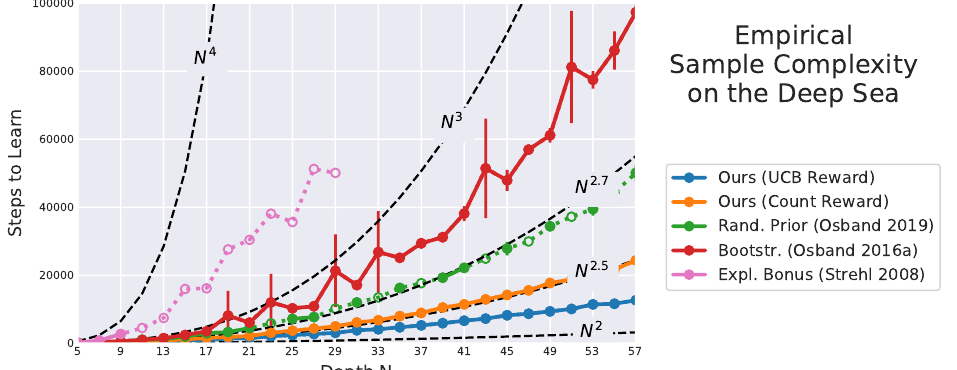
Figure 22. Steps to learn on varying the deep sea size N = 5,7, . . . ,59, averaged over ten runs with 500,000 steps limit. For filled dots, the run always converged, and we report the 95% confidence interval with error bars. For empty dots connected with dashed lines, the algorithm did not learn within the step limit at least once. In this case, the average is over converged runs only and we do not report any confidence interval. Using the exploration bonus (pink) learning barely converged once (most of its dots are either missing or empty). Using bootstrapping (red) all runs converged, but the results show a large confidence interval. With random prior (green) the learning rarely did not converge, and performed very similarly across the random seeds, as shown by its extremely small confidence interval. On the contrary, our method (blue, orange) is the only always converging with a confidence interval close to zero. Indeed, it outperforms all baseline by attaining the lowest sample complexity. Missing algorithms (random, (cid:101) -greedy, UCB1, Thompson sampling) performed poorly and are not